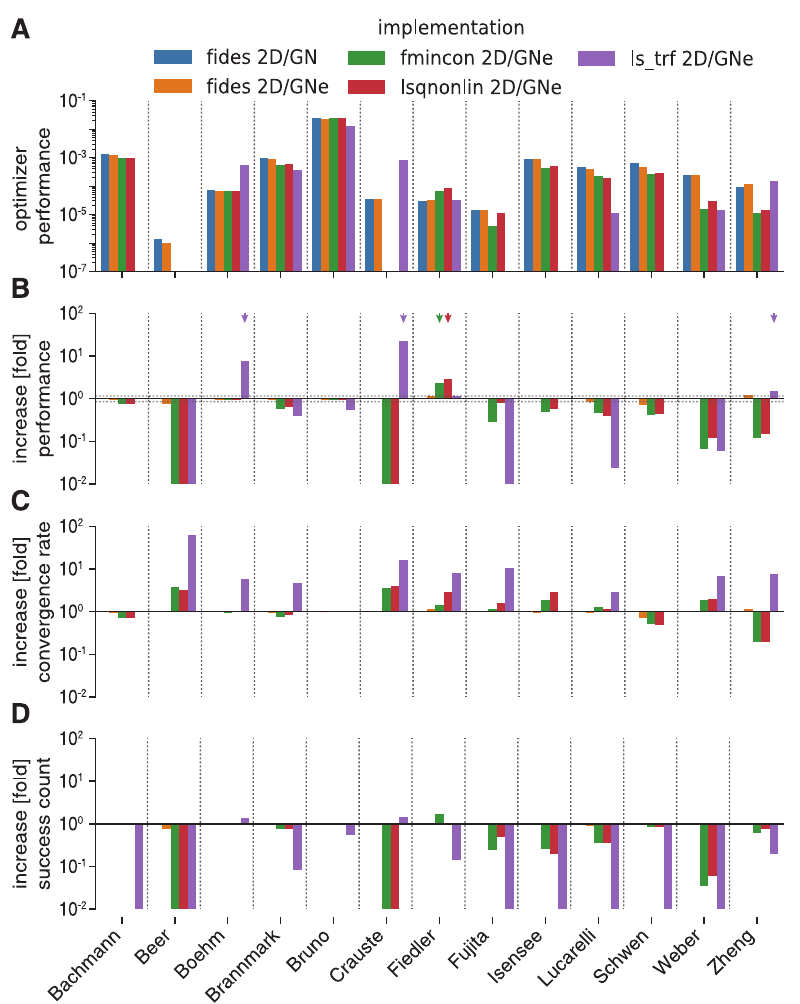
Fig 2. Comparison of MATLAB and Python optimizers. Colors indicate optimizer setting and are the same in all panels. A : Performance comparison ( ϕ ), absolute values. B : Performance comparison ( ϕ ), values relative to fides 2D/GN . C : Increase in convergence count γ , values relative to fides 2D/GN . D : Increase in convergence rate ν , values relative to fides 2D/GN